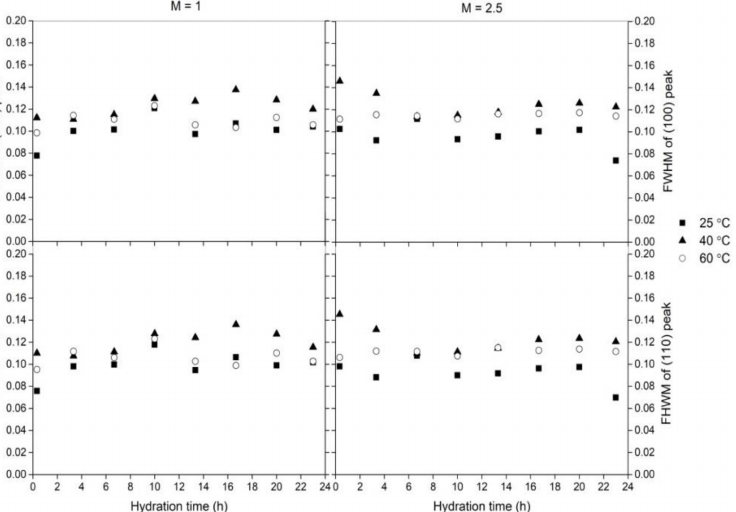
Figure 9. Full width at half maximum (FWHM) of (100) and (110) peaks of ettringite during first 24 h of hydration.